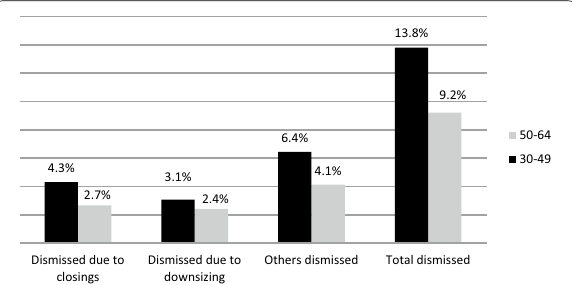
Fig. 2 Dismissal of employees in Israel, by age. Percentage of total employed persons ages 20–75 and over including those dismissed (Source: Israeli Central Bureau of Statistics, 2008, data processed by the